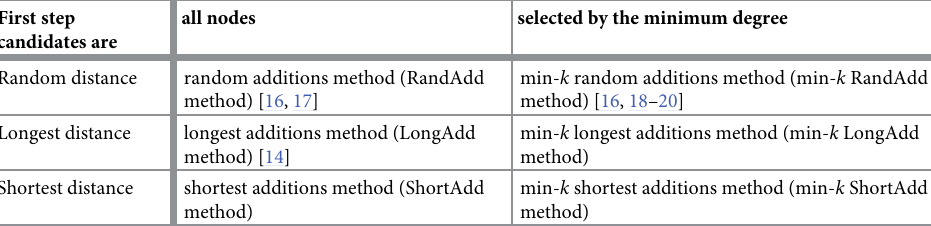
Table 1. Six link addition methods in the combinations of the first step by degree and the second step by